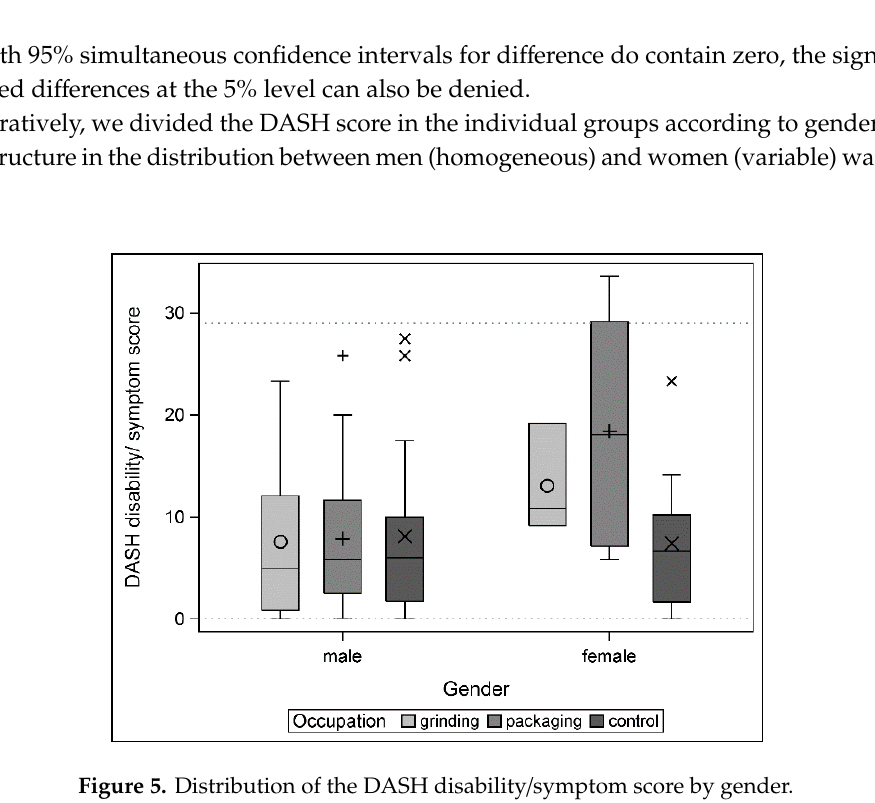
Table 7. Clinical data: prevalence of pathognomonic clinical signs.